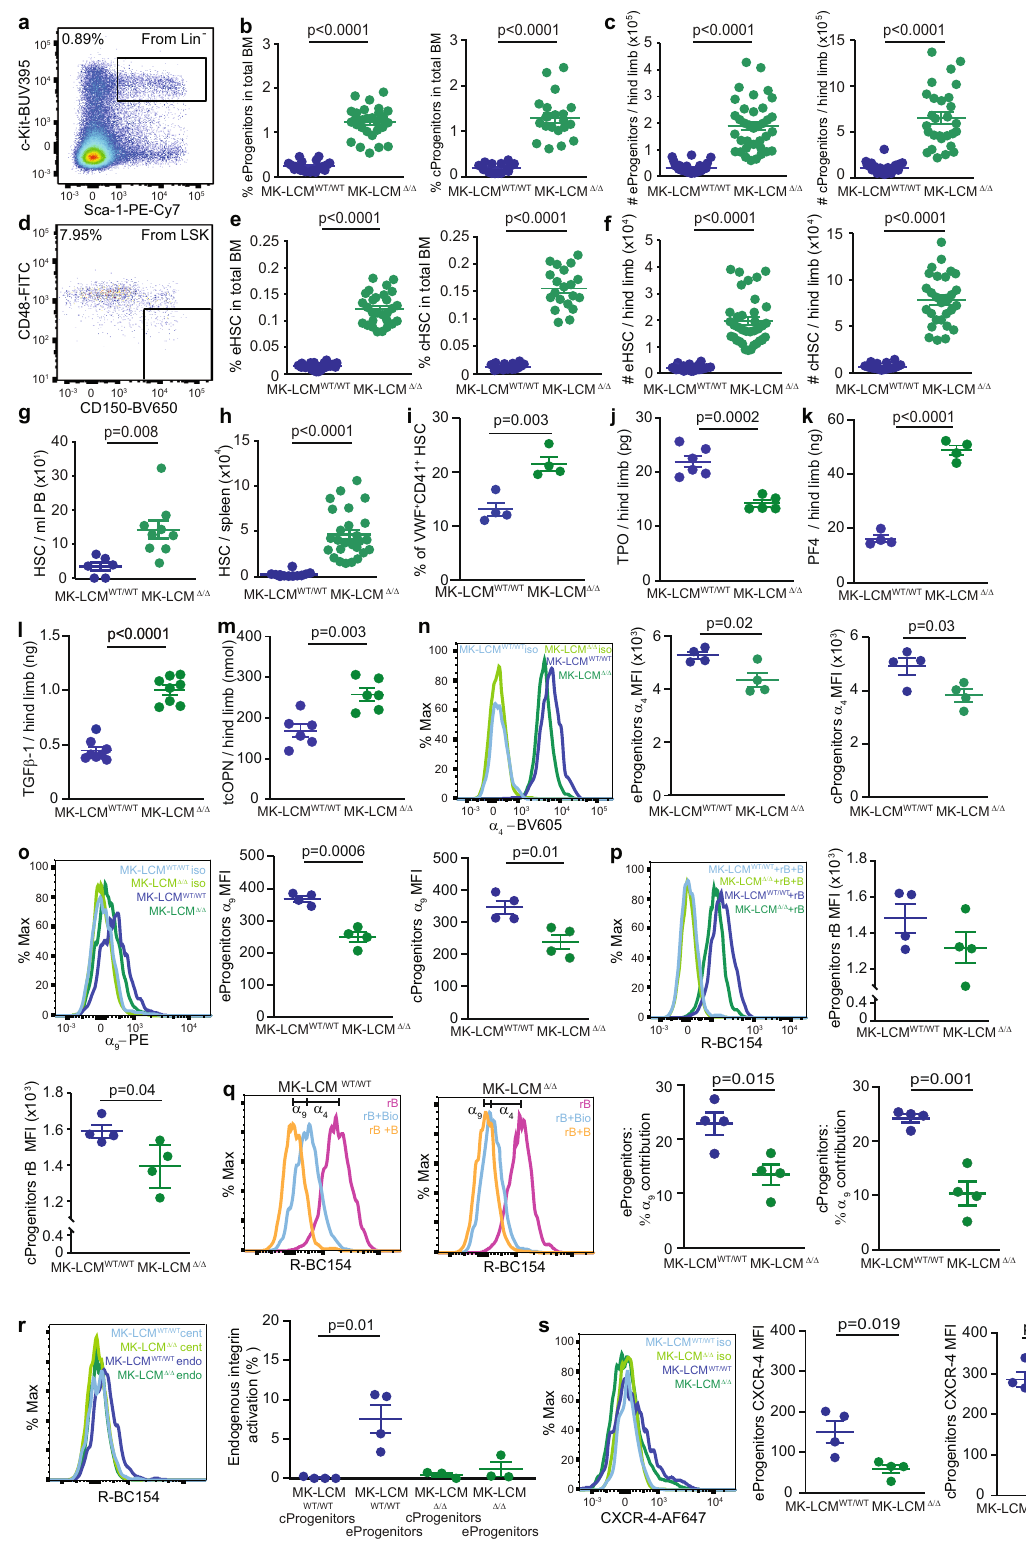
(Fig. 4c, e – h). In contrast, when equivalent numbers of MK-LCM WT/WT HSC were transplanted with HSC from MK-LCM Δ / Δ mice, a